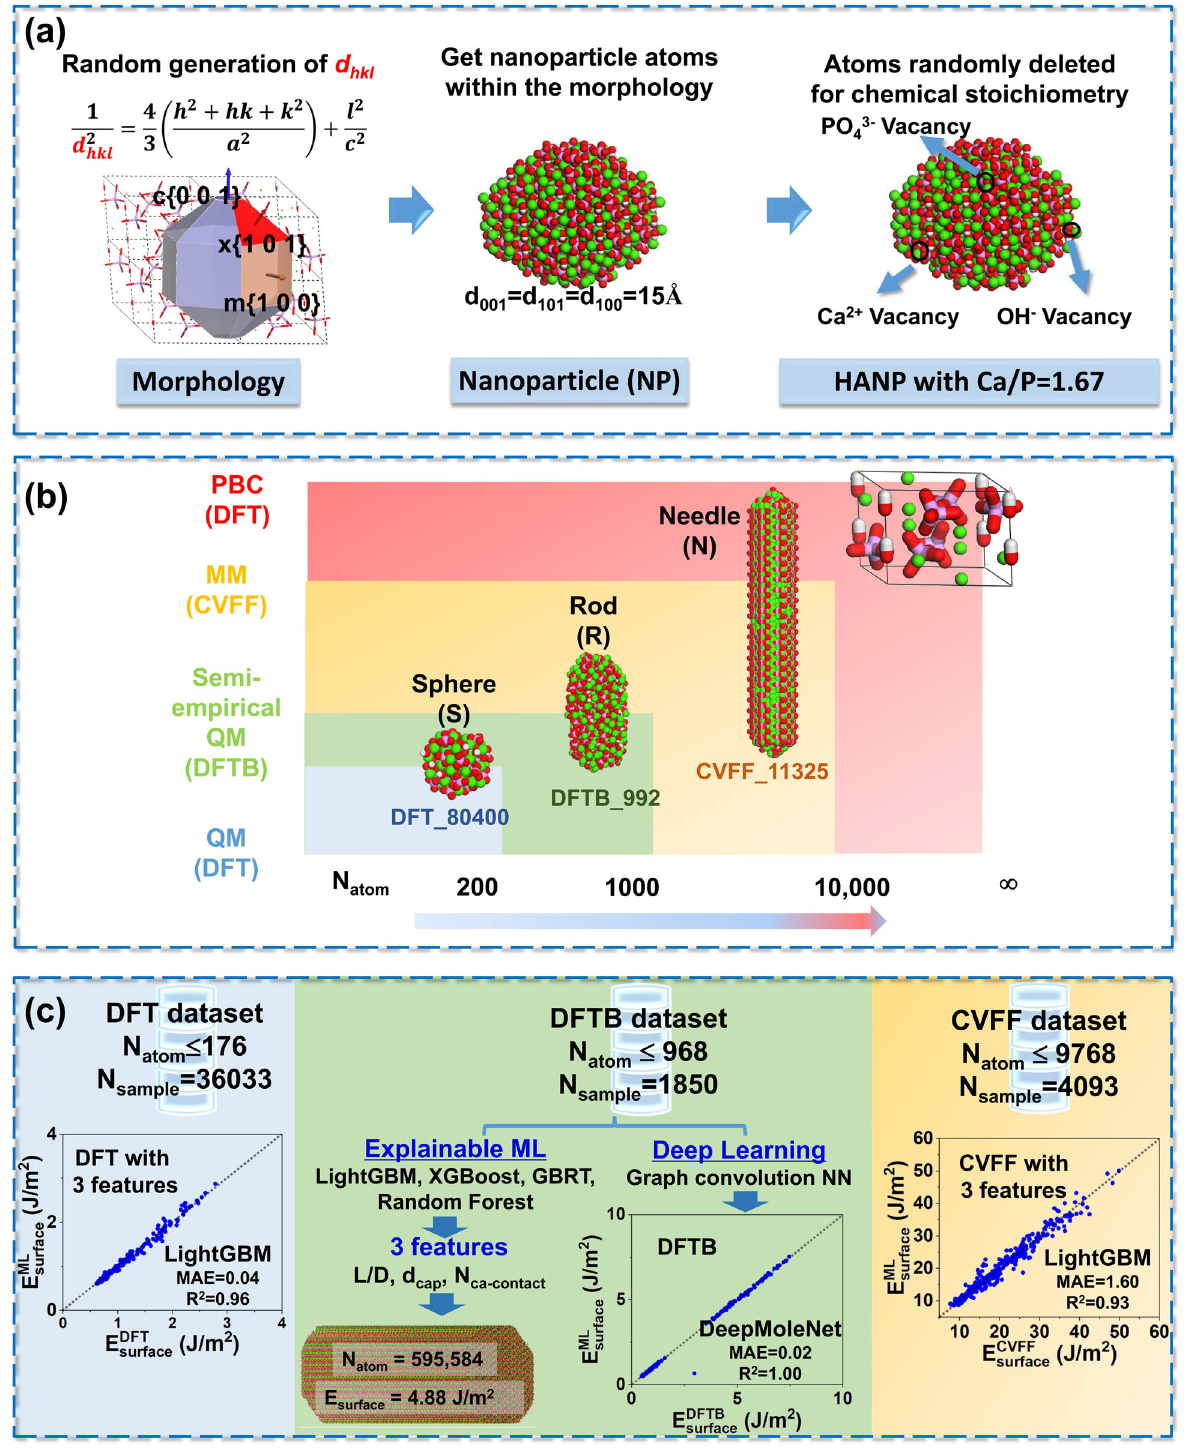
Fig. 2 HANPs generation, multiscale datasets, and machine learning. a Nanoparticle generation from HA crystal structure with chemical stoichiometry. b Datasets at different theoretical levels. c Different machine learning (ML) methods applied to predict